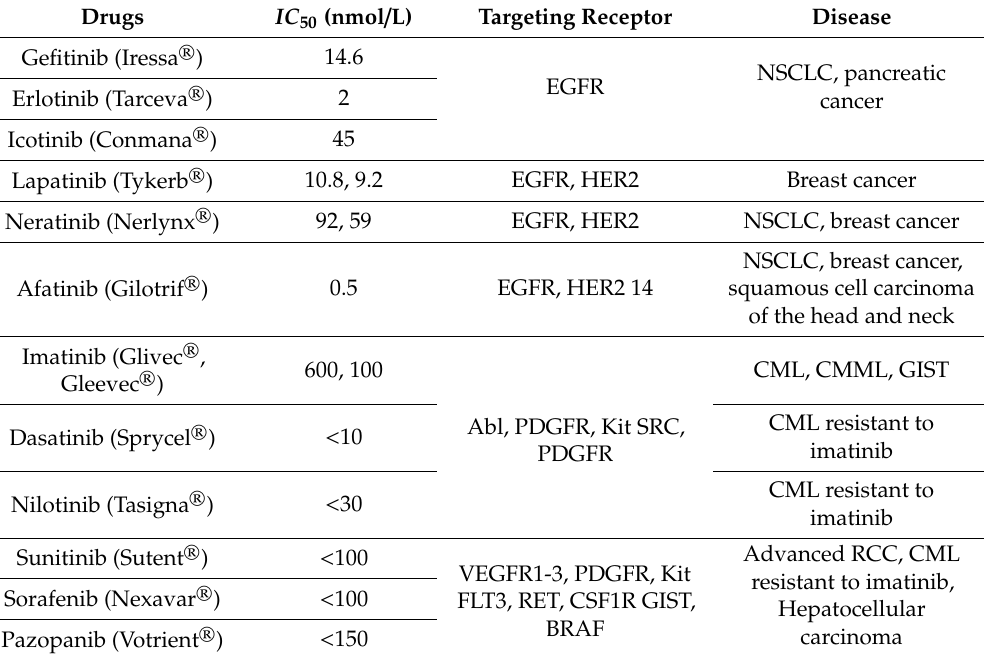
Table 1. Approved small molecular tyrosine kinase inhibitors for cancer therapy